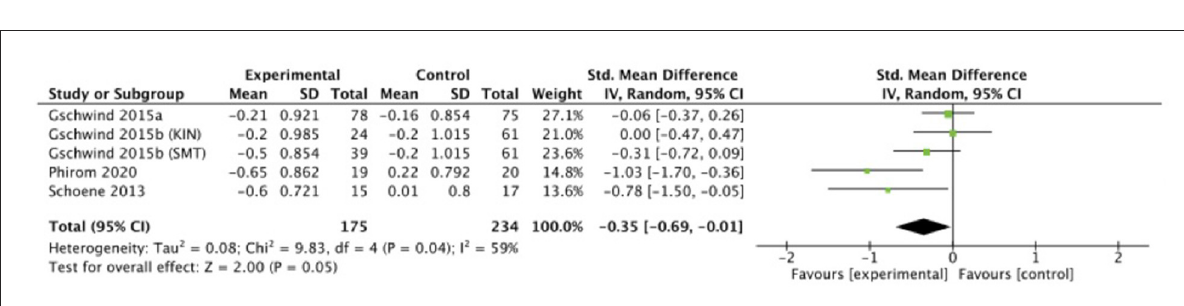
FIGURE7 Random effects meta-analysis forest plot for effectiveness of intervention on measures of PPA physical outcomes.